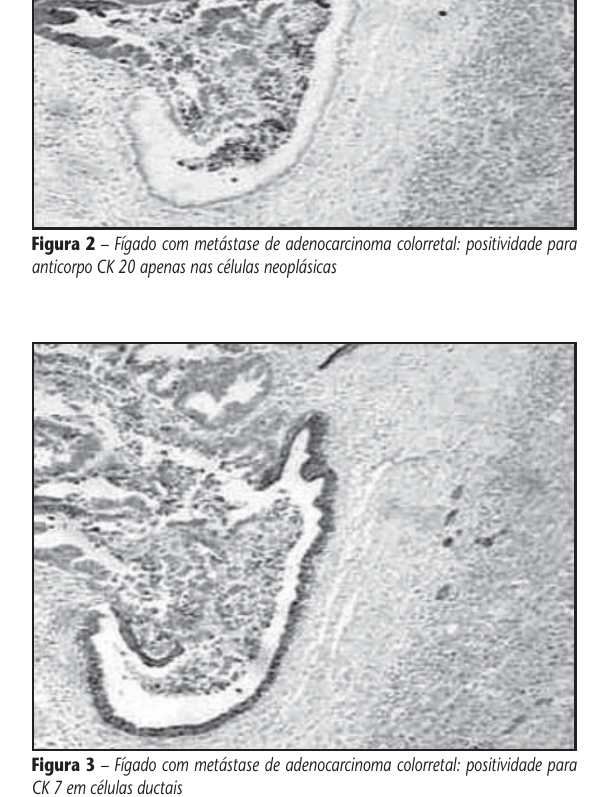
Figura 3 – Fígado com metástase de adenocarcinoma colorretal: positividade para CK 7 em células ductais